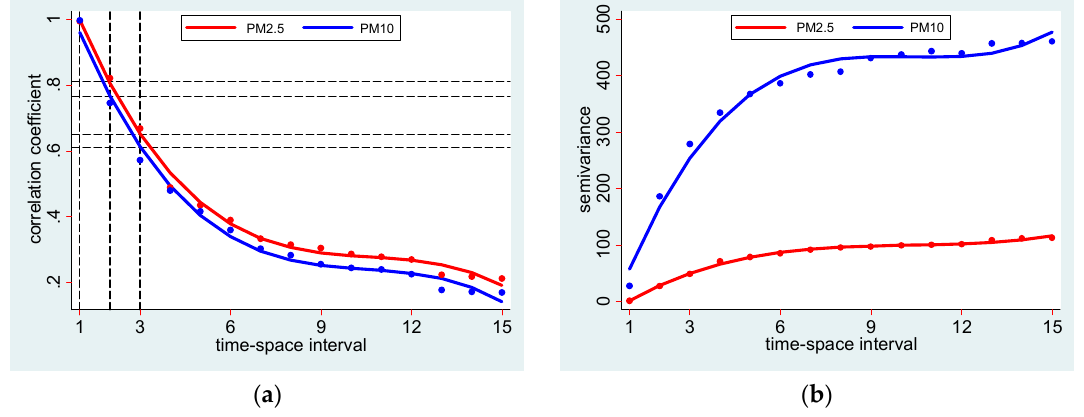
Figure 2. ( a ) Spatiotemporal autocorrelation and ( b ) semivariance of daily PM 2.5 and PM 10 in IL and Cleveland, OH. Time-space interval refers to diagonal interval; 1 = time interval ≤ 1 day and distance interval ≤ 0.025°, 2 = time interval ≤ 2 days and distance interval ≤ 0.05°, …, 15 = time interval ≤ 15 days and distance interval ≤ 0.375°. Table 1. Regression of autocorrelation and semivariance with respect to distance and time intervals. Autocorrelation Variables